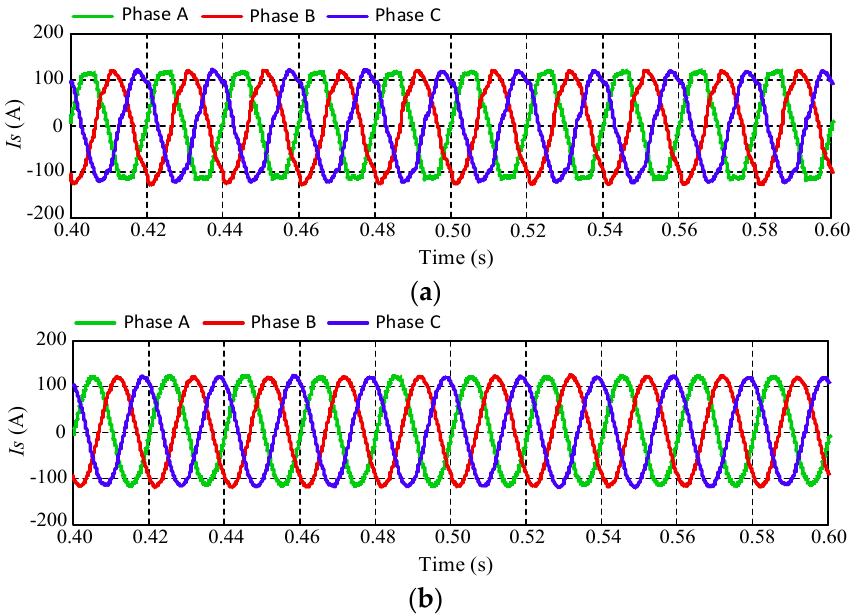
Figure 13. Simulation result about currents in the grid ‐ winding of the new grid ‐ connected transformer when wind farm’s output power is 4.5 MW. ( a ) No filtering; ( b ) With inductive filtering.